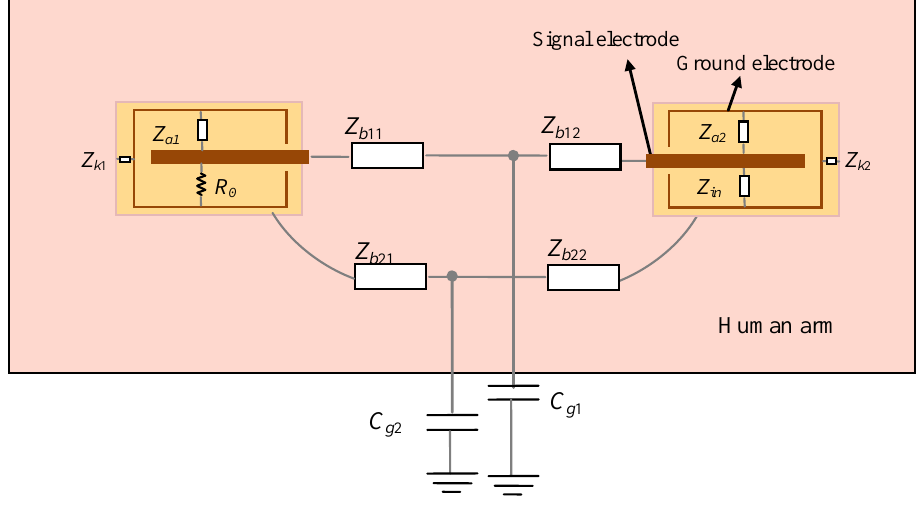
Figure 3. Circuit model of implant IBC based on capacitive coupling.